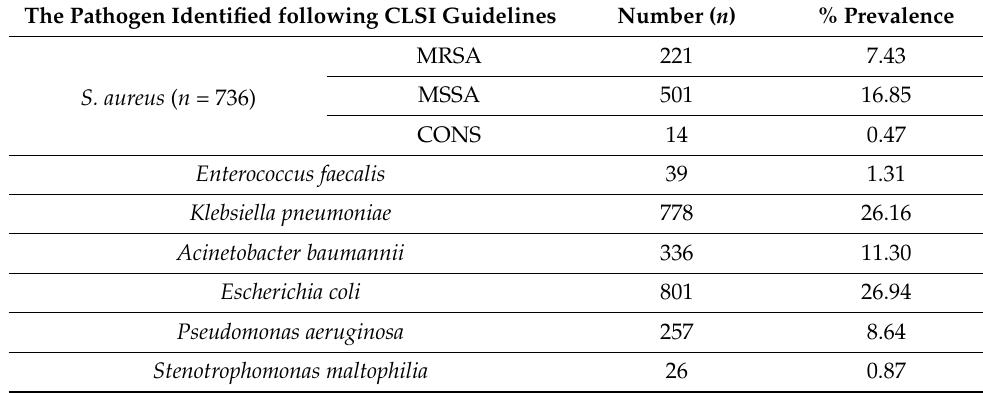
Table 1. Overall prevalence of pathogens isolated from different clinical samples ( n =